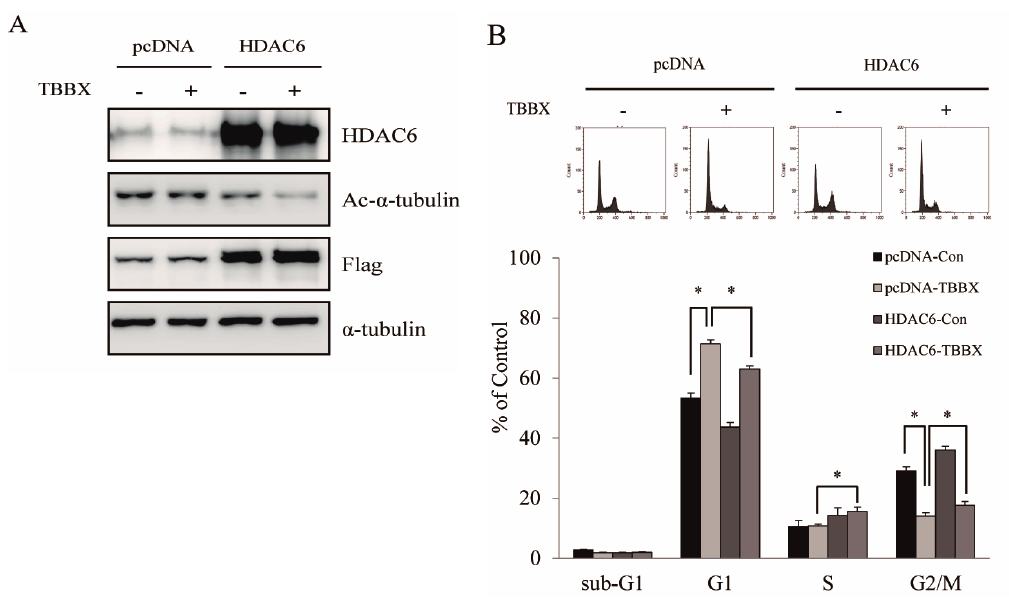
Figure 8. Ectopic expression of HDAC6 rescued TBBX-induced G1 growth arrest in H1299 lung cancer cell . H1299 cells were transient transfected HDAC6-overexpressed plasmid or vector only as described in Materials and Methods. Afterward, cells were treated with 10 μ M TBBX for 24 h. ( A ) Cells were then harvested and Western blotting analyses performed by anti-HDAC6, acetyl- α -tubulin, flag-tag and anti- α -tubulin. Data shown are representative of at least three independent experiments. ( B ) After TBBX treatment, cell cycle analyses were done as described in Materials and Methods. Data